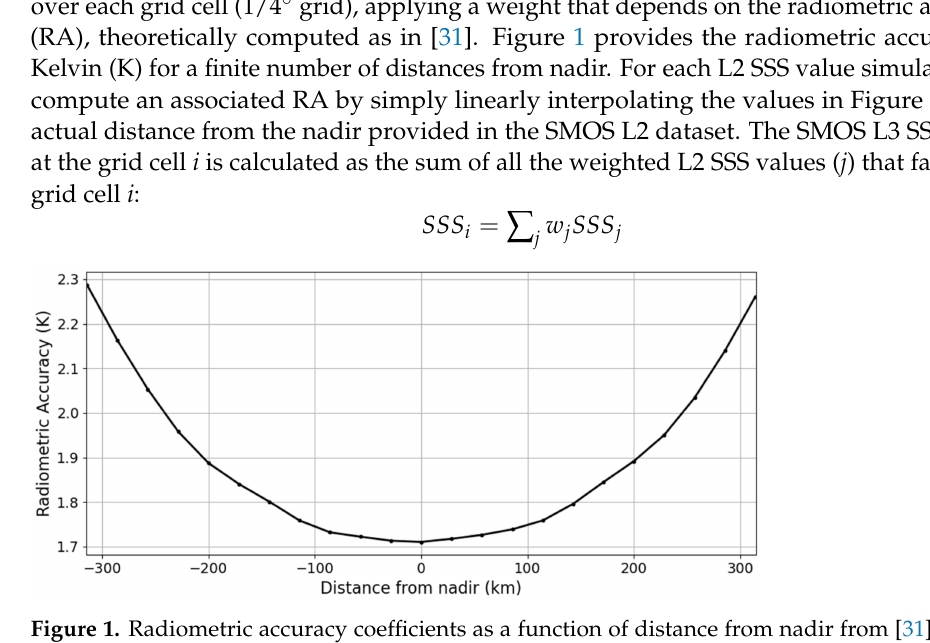
Figure 1. Radiometric accuracy coefficients as a function of distance from nadir from [31] used to compute the simulated L3 SMOS SSS